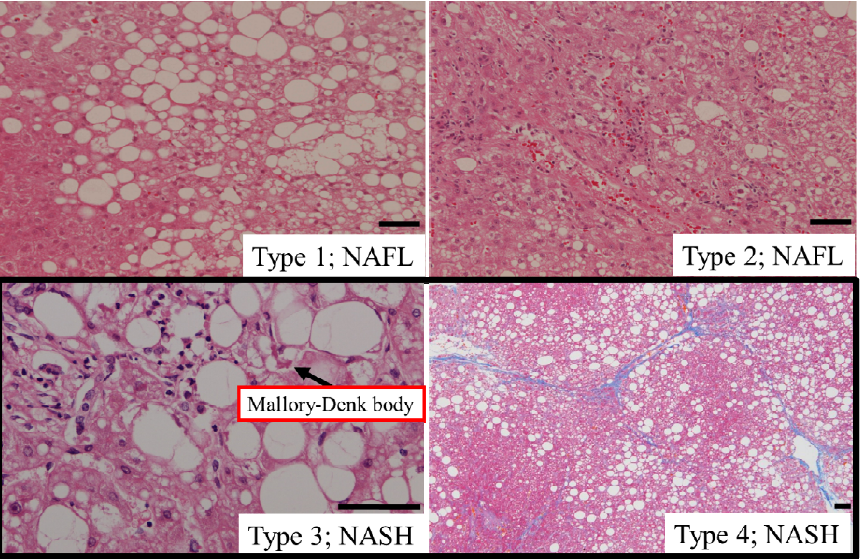
Figure 1. Histological findings of NAFLD. Liver biopsy specimens of NAFLD patients are shown. Representative findings of four classifications are shown, as reported by Matteoni et al. in 1999 [2]. Type 1 : steatosis alone (×100, Hematoxylin and eosin (H and E) staining); Type 2 : steatosis with lobular inflammation (×100, H and E staining); Type 3 : steatosis with hepatocyte ballooning (×200, H and E staining) and Mallory-Denk body; Type 4 : type 3 plus either Mallory-Denk bodies or fibrosis (×40, Azan staining). Scale bar: 50 μ